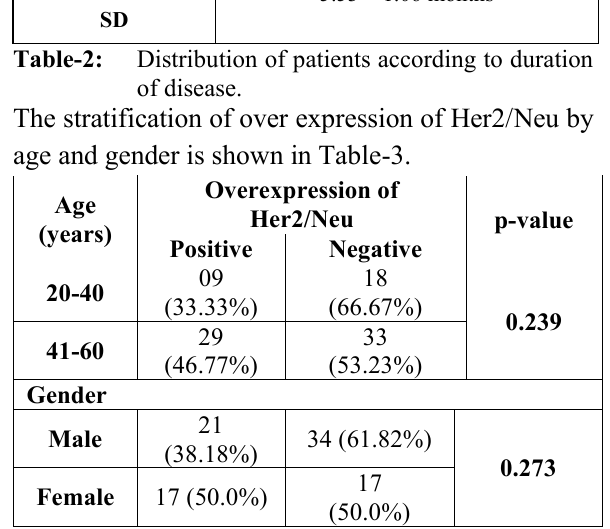
Table-4: Stratification of over expression of Her2/Neu with respect to duration & stage of disease.